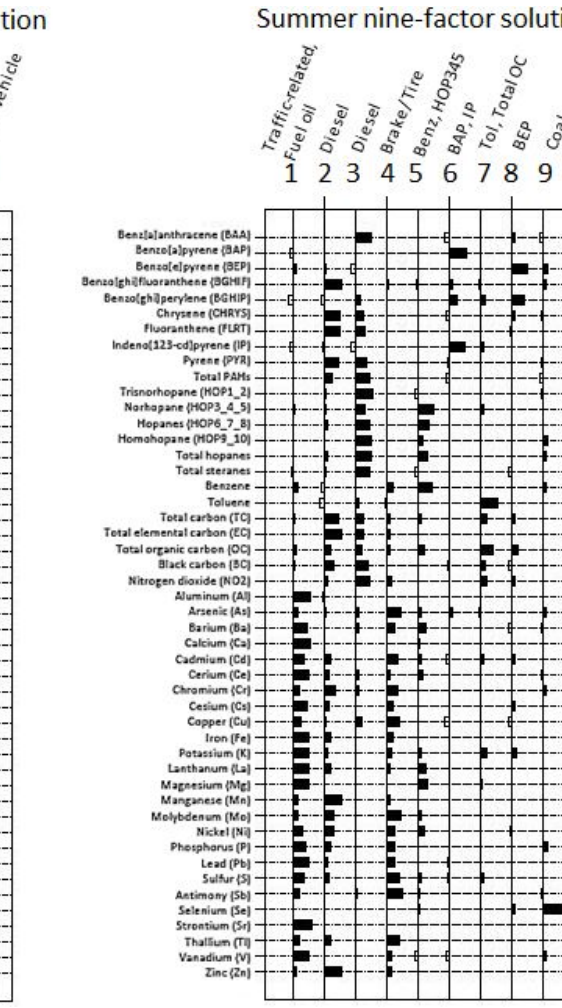
Figure 1. Factor loadings plot for winter five-factor and summer nine-factor solutions ( n = 36). For winter samples, a five-factor solution explained 88% of overall variability across constituent concentrations. Factor one (which explained 50% of total variance) was characterized by several organic compounds, and interpreted as ‘traffic-related organic.’ Factor two (24%), interpreted as ‘traffic-related elemental’, was characterized by elemental constituents (Figure 1). Factor three (7%) included ‘diesel tracers’ (BC, fluoranthene, NO 2 , pyrene, total carbon). Factor four (4%) included ‘fuel oil tracers’ (Ni, V), while factor five (3%) suggested ‘motor vehicle’ (benzene, Cd, La,